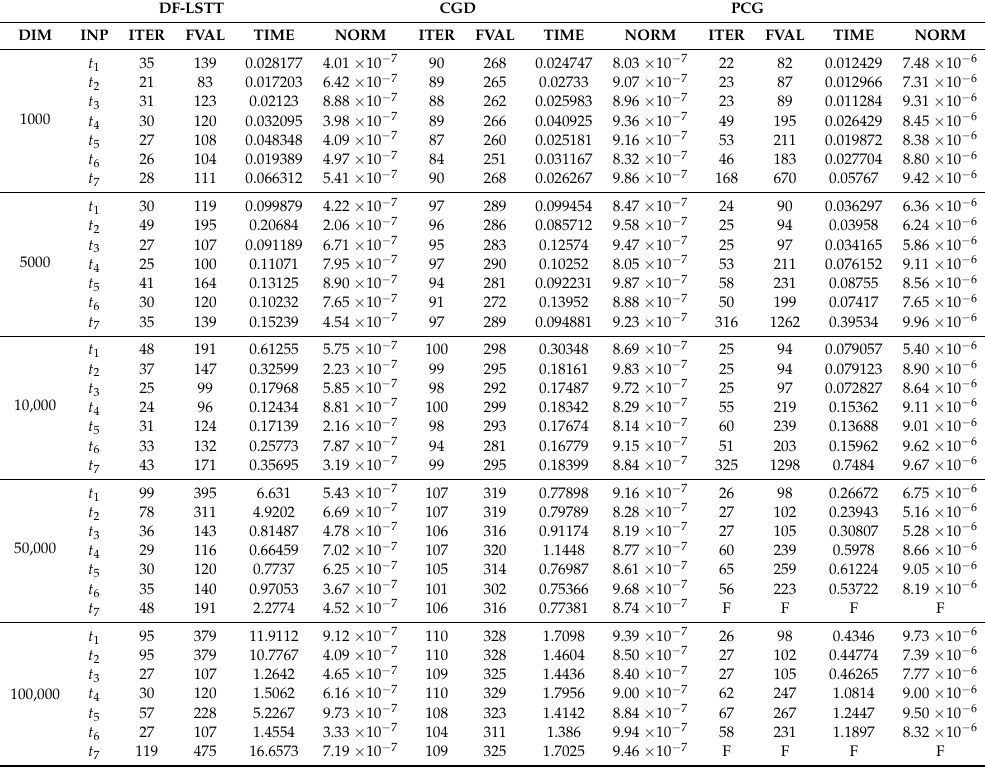
Table 7. Numerical test reports for the three tested methods for Problem